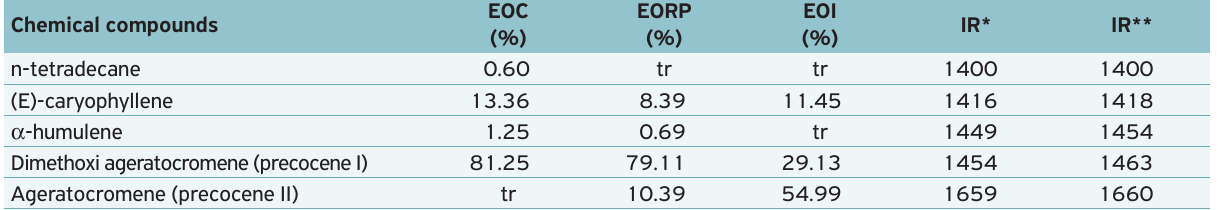
Table 2. Chemical composition of essential oils of leaves of A. conyzoides collected in Campinas, Ribeirão Pires and Ibiúna.